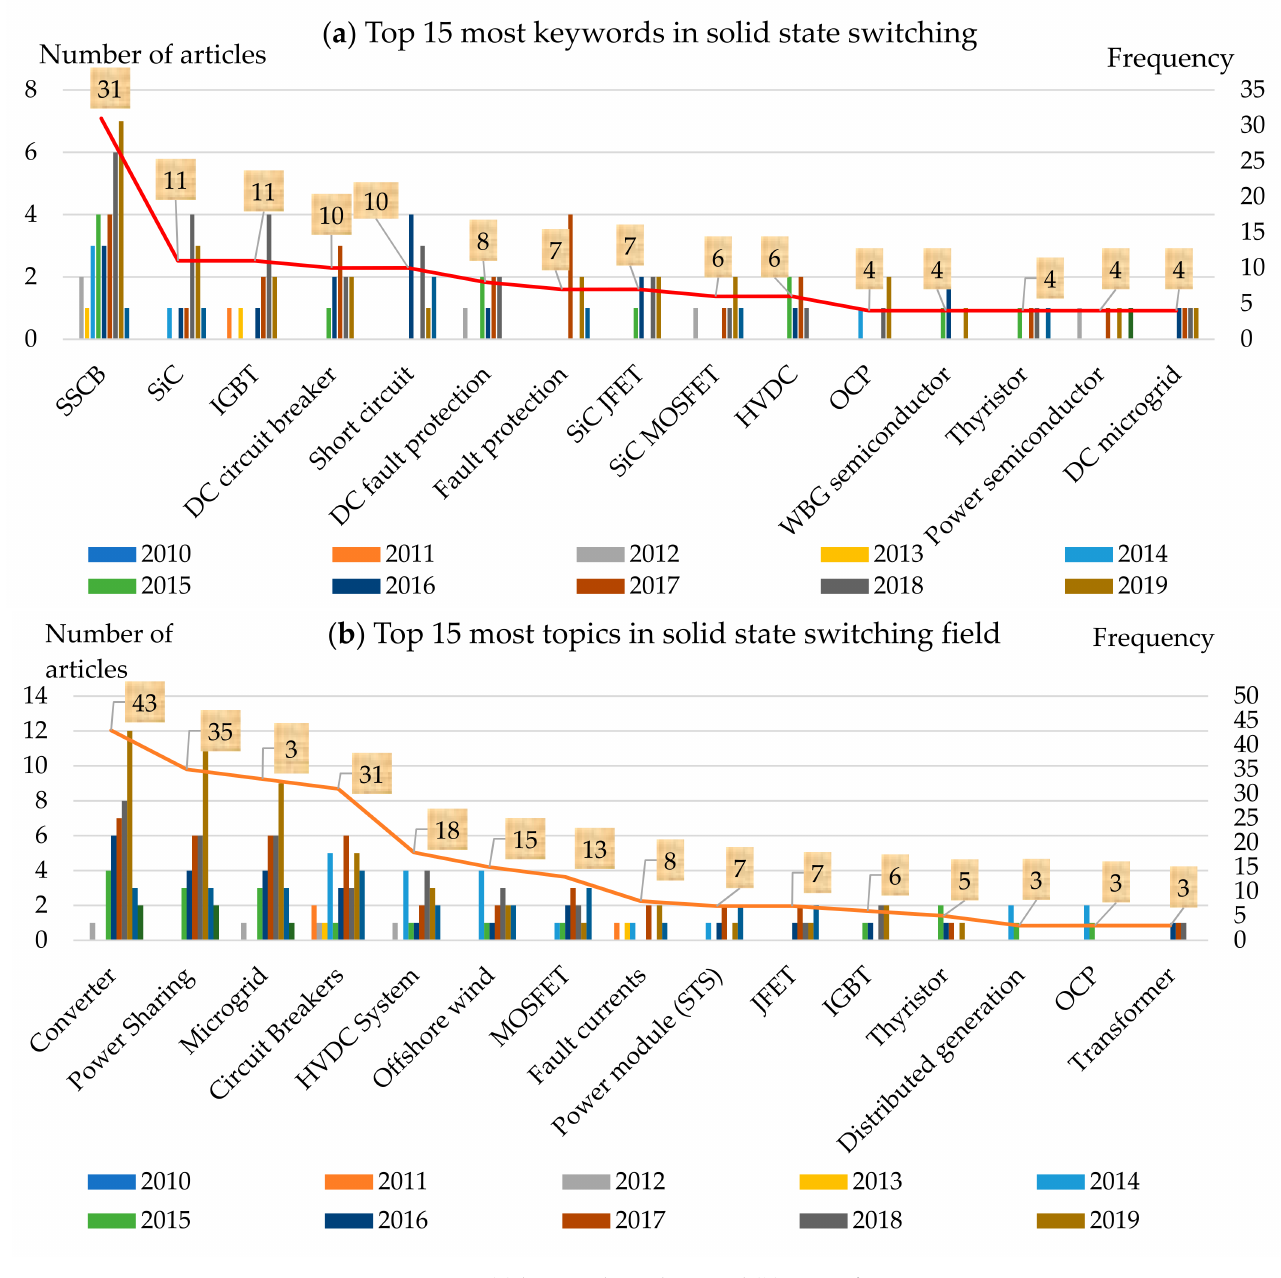
Figure 5. Common ( a ) keywords analysis and ( b ) topics for 120